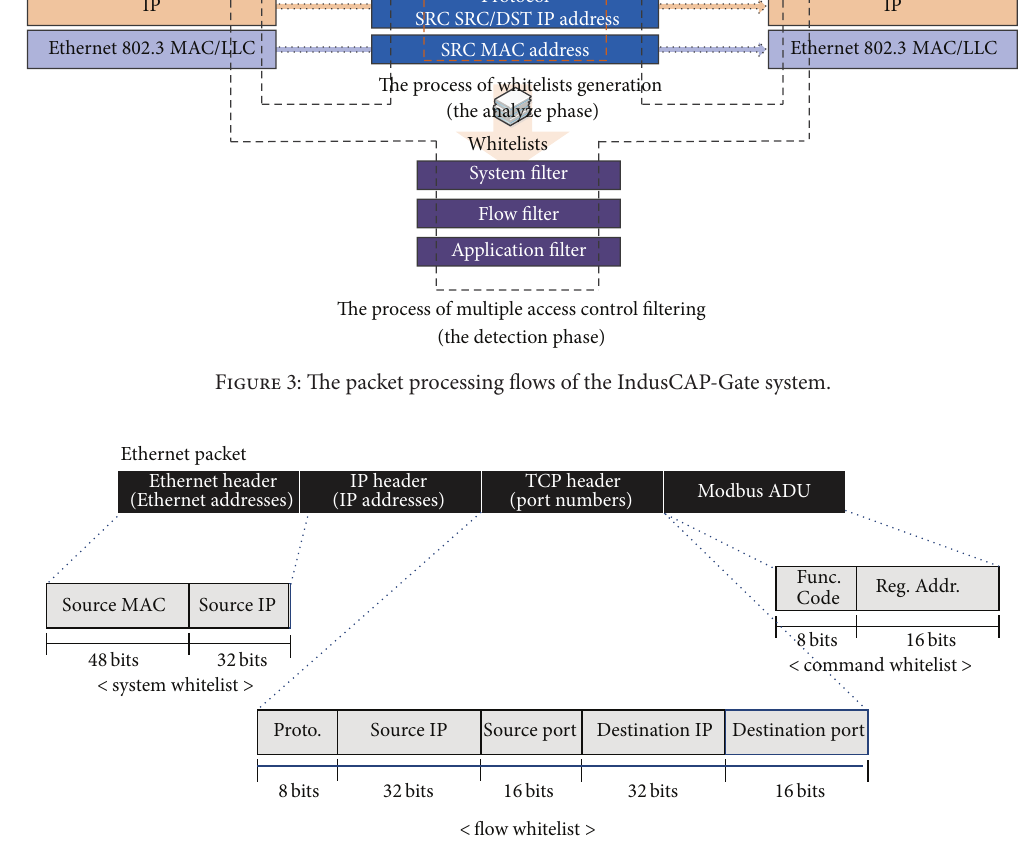
Figure 4: The format of